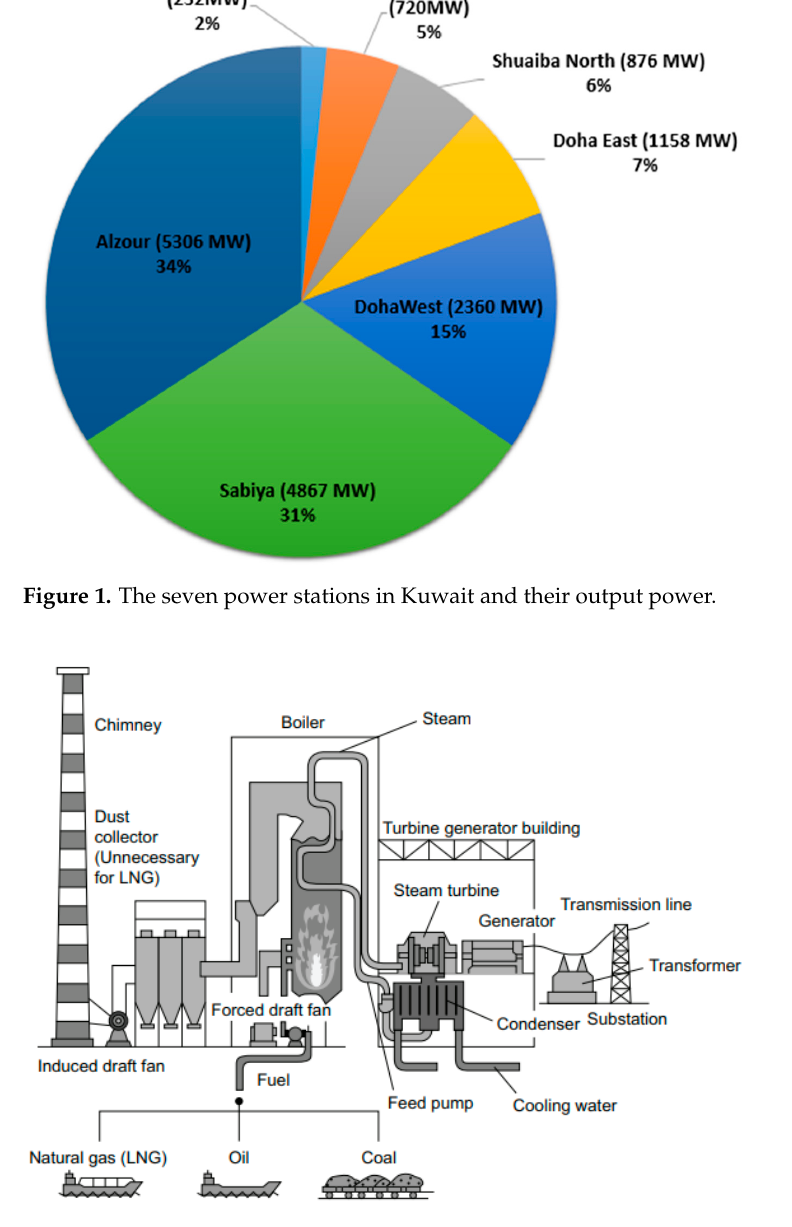
Figure 1. Power generation from the combustion of fossil fuel [7]. Figure 2. Power generation from the combustion of fossil fuel